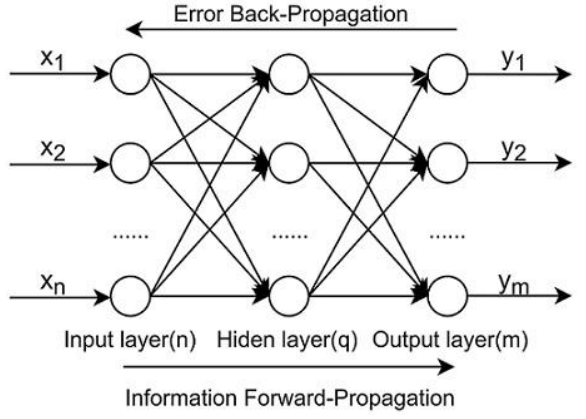
Figure 4. Three-layer BP neural network model.